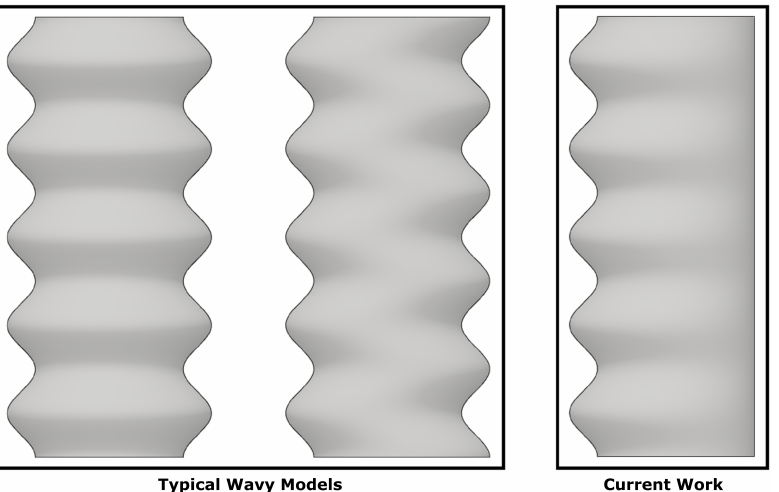
Figure 1. Types of wavy cylinders (in each cylinder, the leading edge appears on the left and the trailing edge on the right). The right-most cylinder shows the waviness adopted in the current work, whereas the other two cylinders show the typical patterns of waviness considered in the